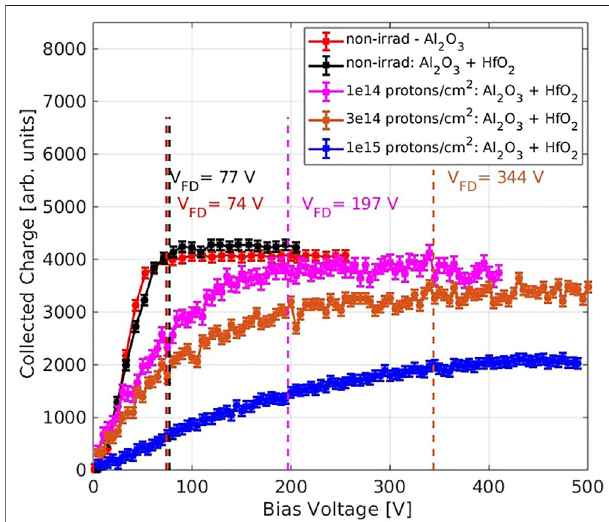
FIGURE 11 | Variation in collected charge versus bias voltage sweep from the front IR laser illumination TCT characterization method for non- irradiated and irradiated pixelsensors atvaryingproton fl uences, measured at − 15 ° C.